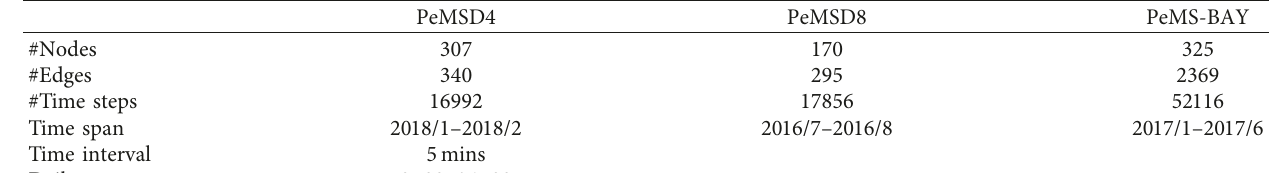
Table 1: The details for PeMSD4, PeMSD8, and